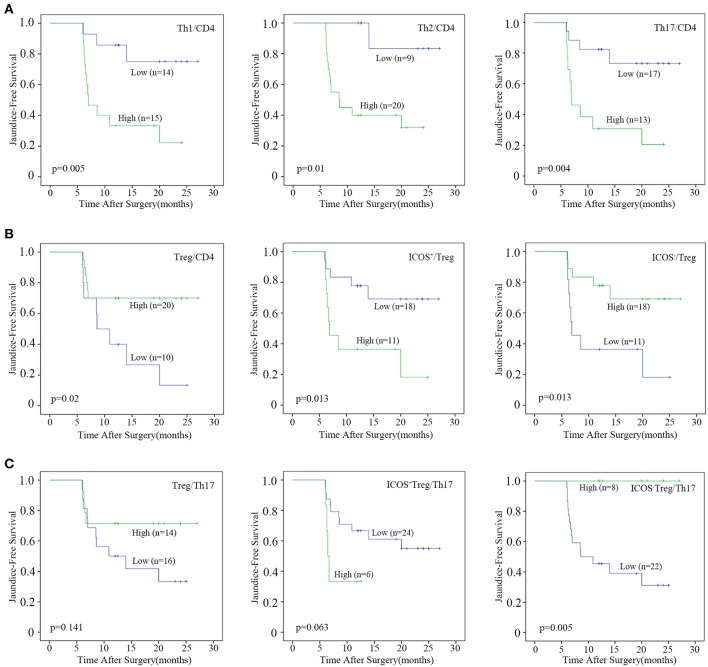
Prognostic analyses of CD4+T cell subsets. Patients were divided into “high” and “low” groups according to the optimal cut-offs which were determined by ROC curve analysis. Kaplan–Meier analysis of jaundice-free survival for (A) the percentages of Th1, Th2, and Th17 cells, (B) the percentages of Treg, ICOS+Treg, and ICOS−Treg cells, (C) the ratio of Treg, ICOS+Treg, and ICOS−Treg to Th17 were analyzed. Log-rank test was used.